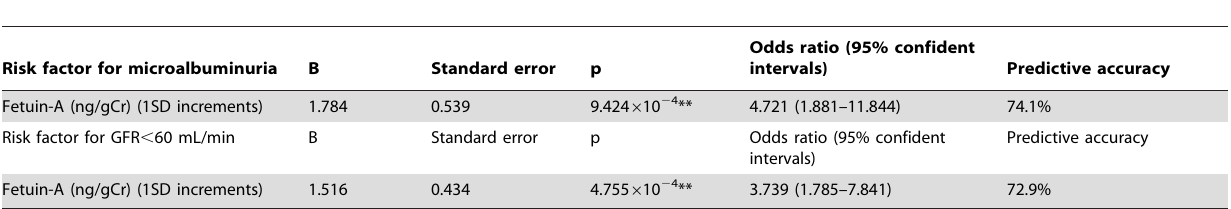
Table 8. Stepwise multivariate logistic regression analysis to assess the urinary sialylated glycoprotein excretions as a risk for diabetic nephropathy with microalbuminuria or glomerular filtration rate (GFR) , 60